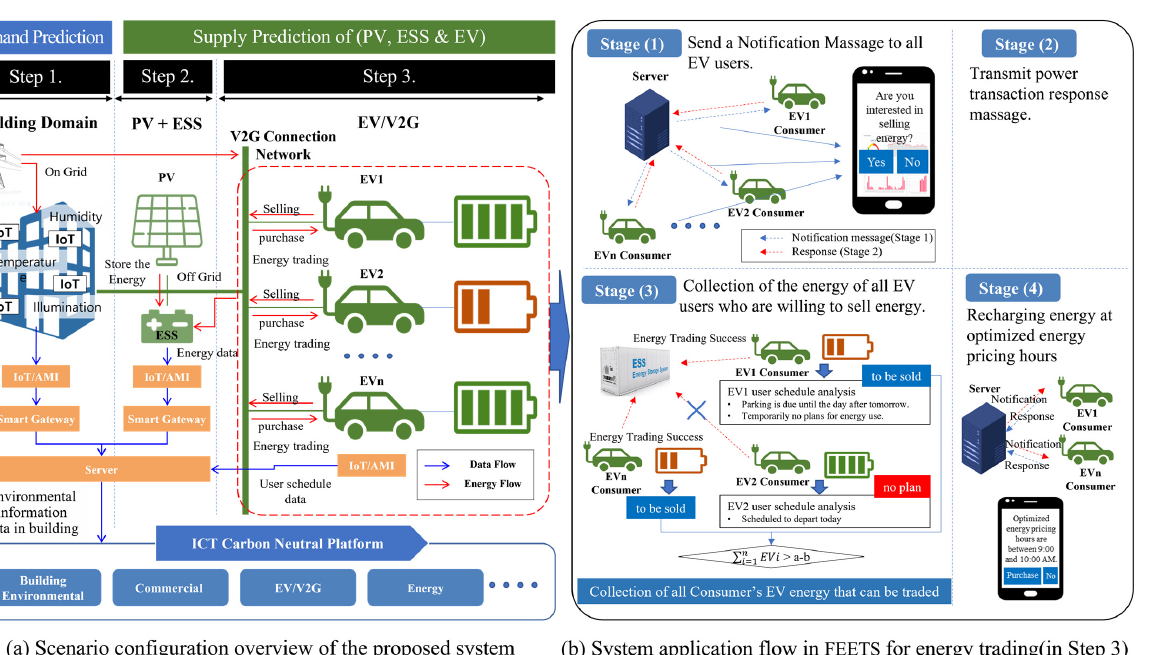
Figure 12. Building with PV and ESS connections and a FEETS overall Scenario.